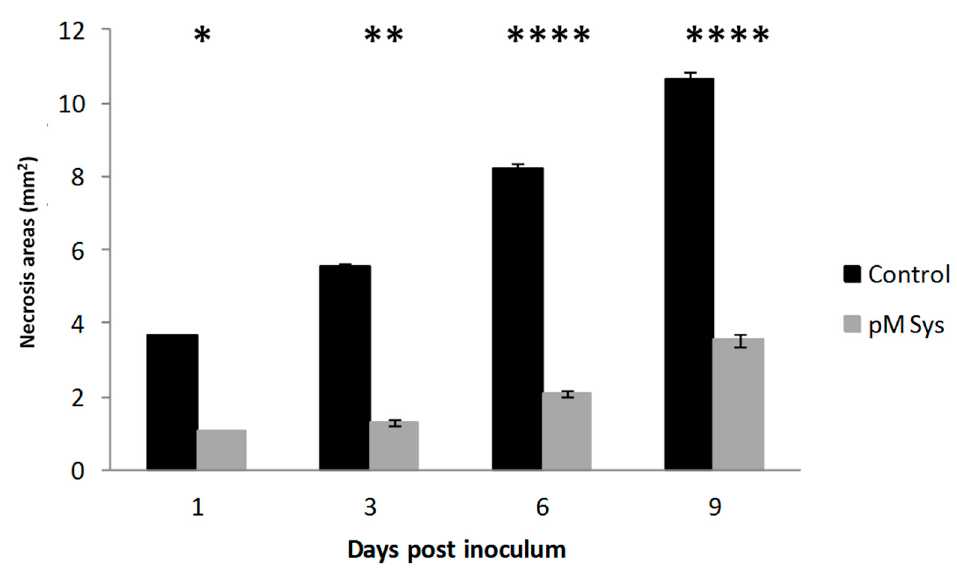
Figure 4. Enhanced resistance to Botrytis cinerea of Sys treated leaves. Response to B. cinerea infection by leaves of plant treated with 100 pM Systemin. The graphs display the average (± S.D.) of the lesion size at 1, 3, 6 and 9 days post inoculum. Asterisks denote statistically significant differences (T-test: * p < 0.05; ** p < 0.01; *** p < 0.001; **** p < 0.00001).